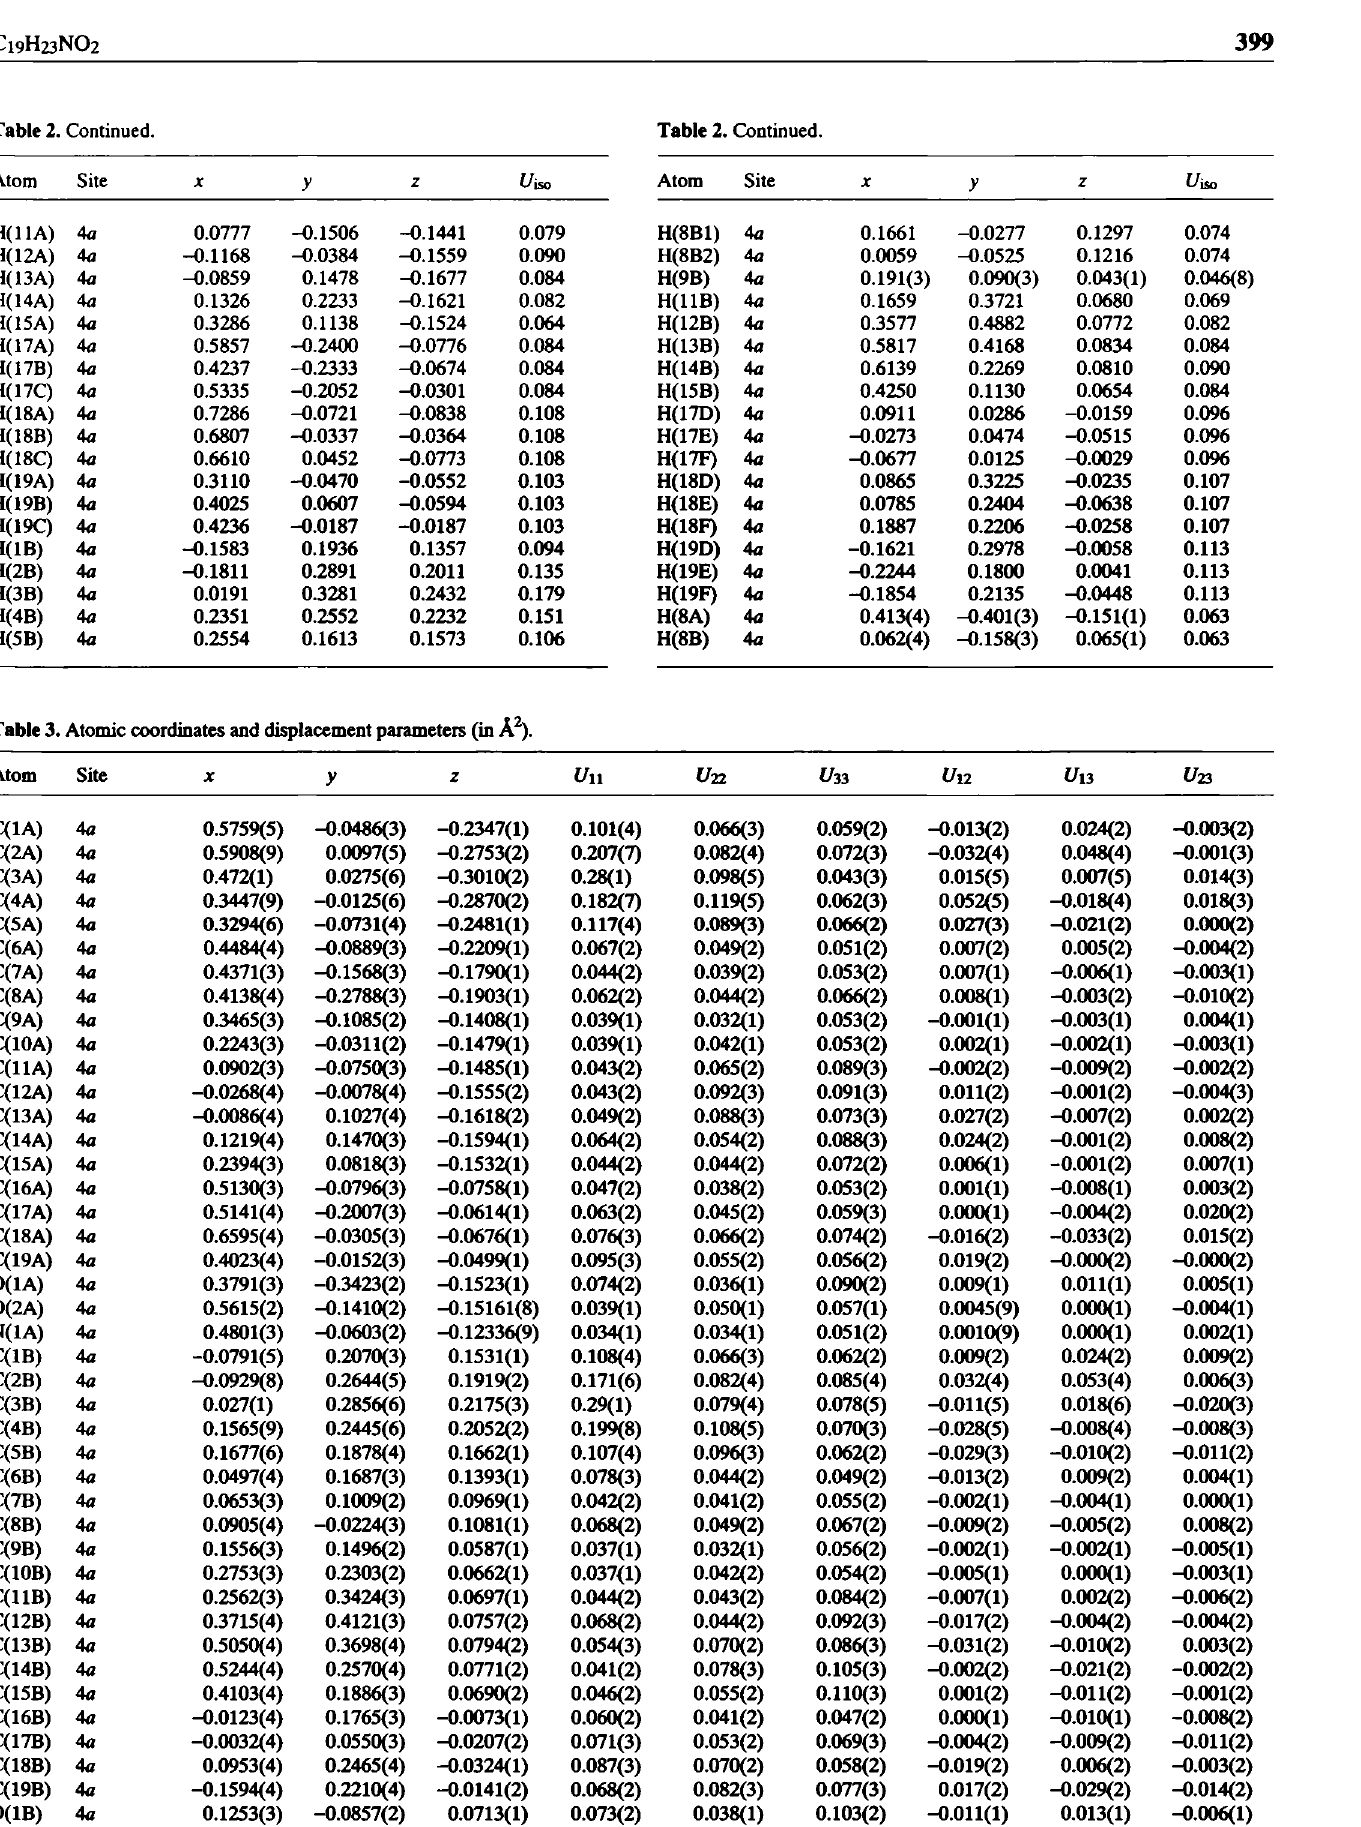
Table 3. Atomic coordinates and displacement parameters (in A 2